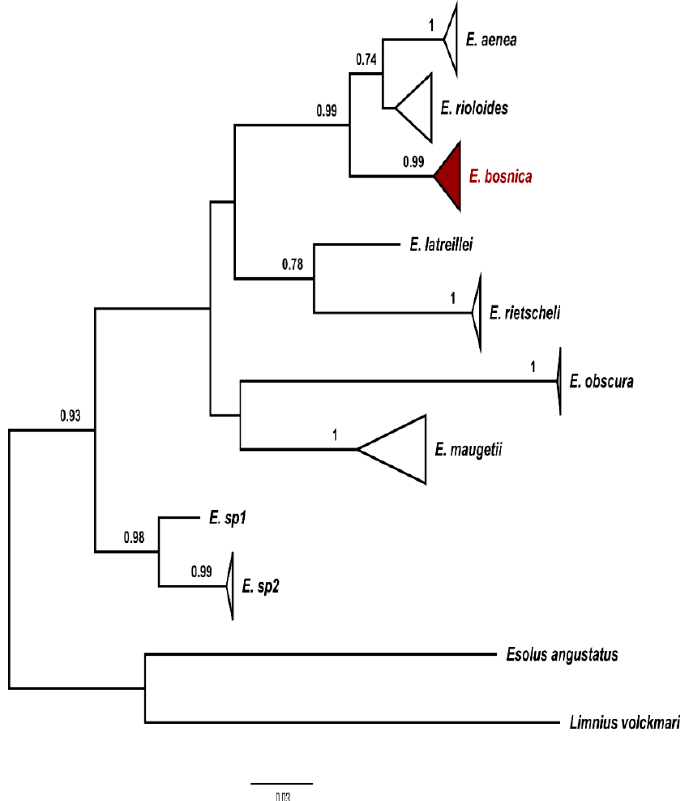
Figure 5. Maximum likelihood phylogenetic tree based on sequences of COI barcoding fragment of Elmis species publicly available in BOLD. Species clades are collapsed for simplicity; aLRT values are indicated on the nodes (values lower than 0.7 are not shown).